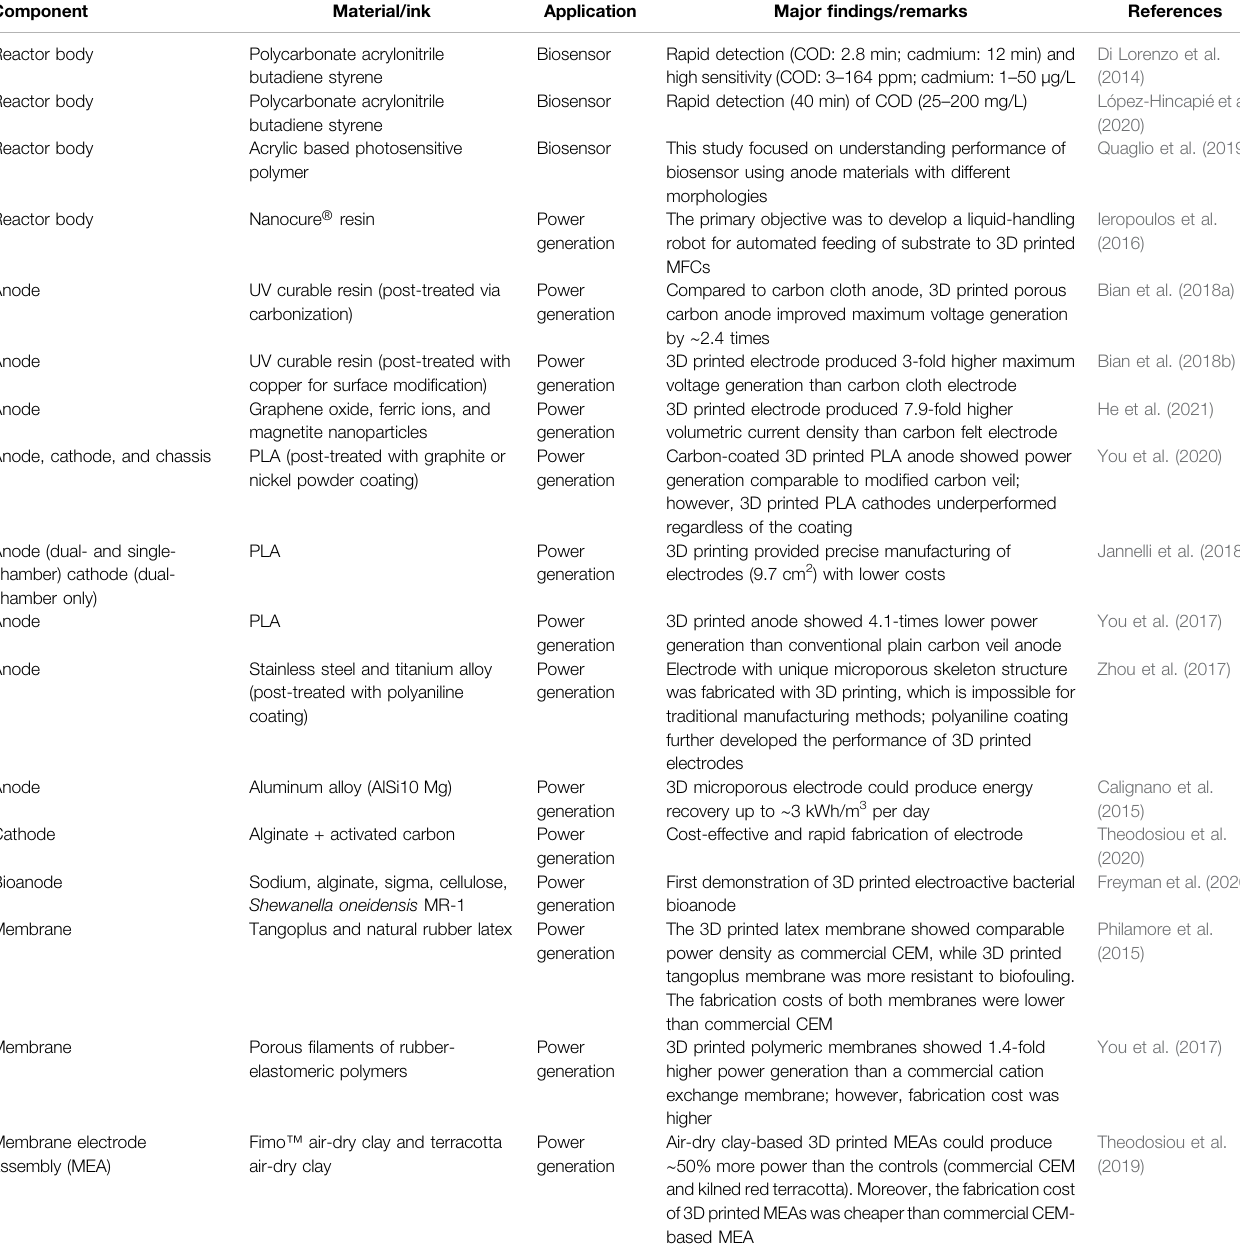
TABLE 1 | Summary of studies used 3D printing for the fabrication of key components in microbial fuel